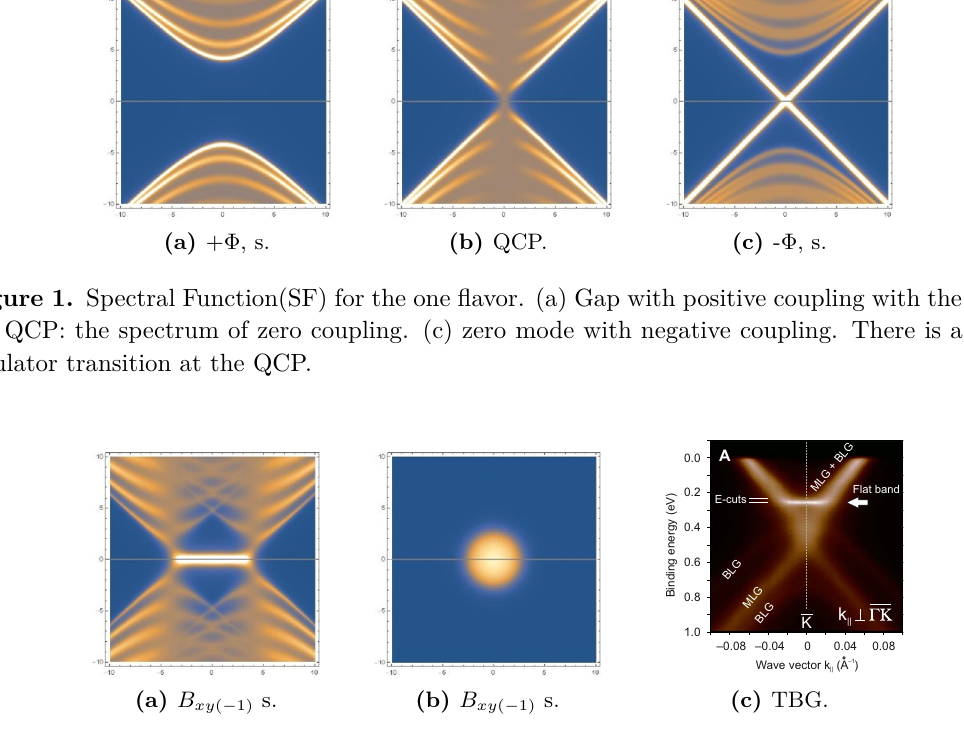
Fig. 1. Angle-resolved photoemission spectroscopy. ( A ) Data for the sample with 1.2 monolayer graphene (MLG) coverage around the ! K point of the graphene Brillouin zone. The MLG Dirac cone dispersion, the faint BLG dispersion, and an intense nondispersing flattened band at 255-meV binding energy, marked by a white arrow,canbeseen.Measurementsweredoneat h n =62eVand T =60K.( B )Firstderivativewithrespecttoenergyfromthesamedataasin(A)wheredispersionsofall bandsaremuchmorevisible.Abluearrowshowsthepossiblepresenceofonemoreflatband.( C )Measurementsinthe G Kdirectionshowingadestructiveinterference effectforthemonolayerandbilayerbandsanditsabsencefortheflatband.( D )Constantenergycutstakenat235-and255-meVbindingenergies.( E )Samedataasin (A)presentedasastackofspectra(onlyevery10thspectrumisshown).( F )Spectraatthe ! Kpointshowingtheflattenedbandintensityanditsnarrowwidth.( G )Dispersionof the maxima extracted from the spectra.